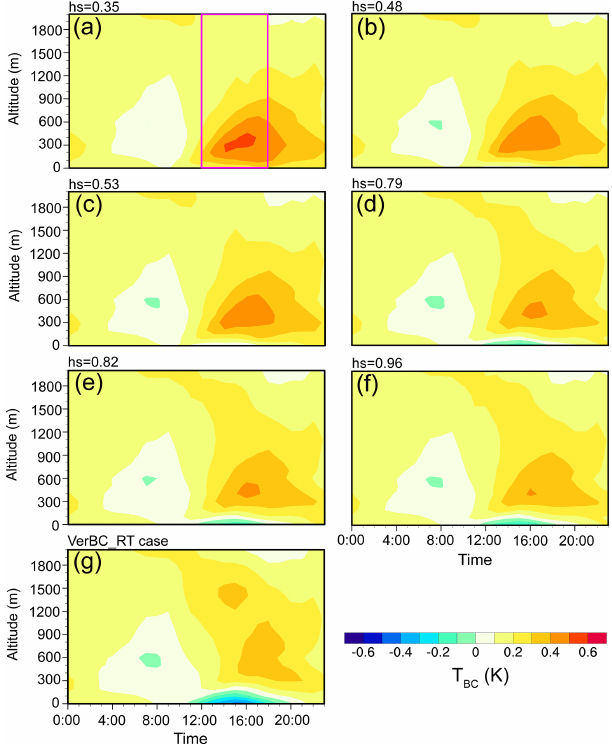
Figure 12. Time series of changes in vertical temperature induced by BC DRE with six exponential functions (VerBC_hs1-6 minus NoBCrad) and one transport-dominated vertical profile (VerBC_RT minus NoBCrad) averaged over 12 and 16–19 December